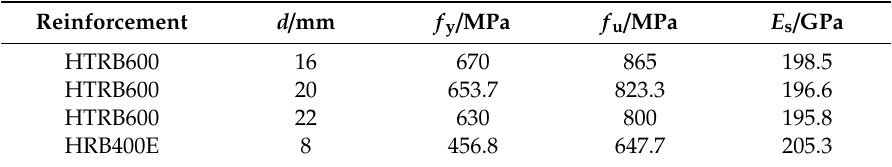
Table 2. Mechanical properties of steel bars.